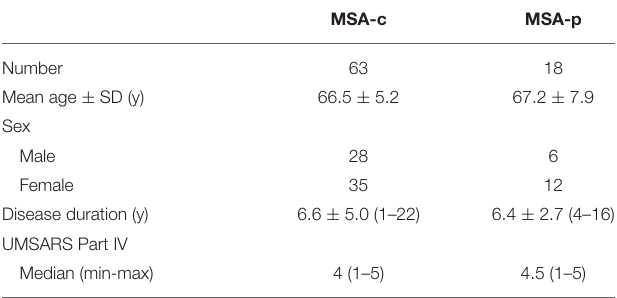
TABLE 1 | Demographics of the study 1 sample.